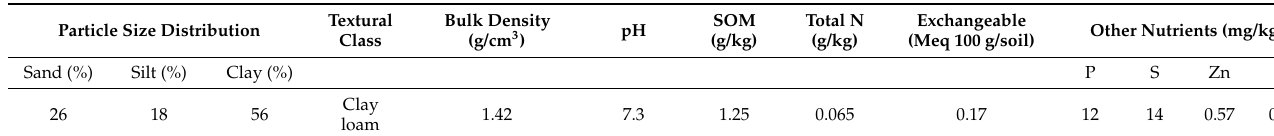
Table 6. Soil properties at 0–15 cm soil depth.